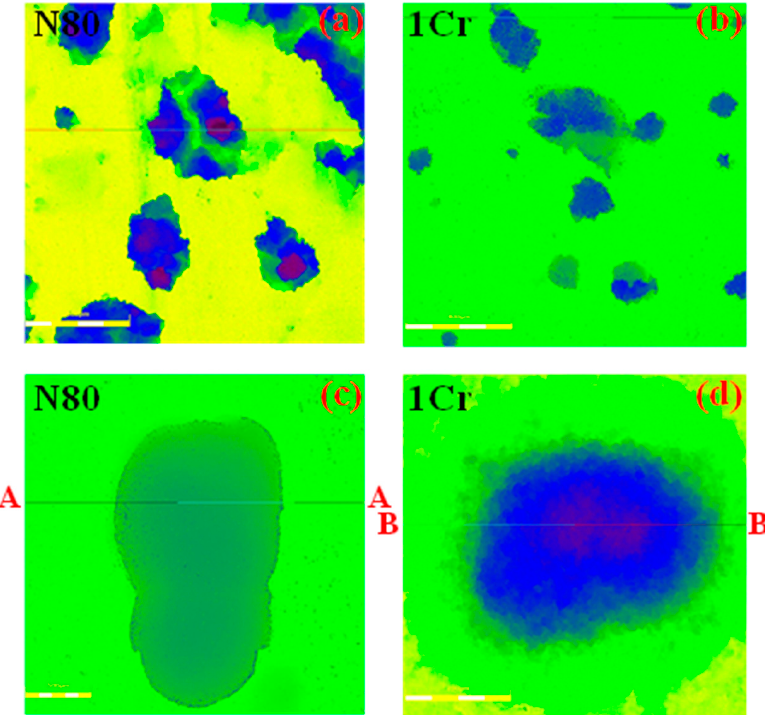
Figure 8. Micrographical analysis of the pi tt ing corrosion at lower temperature-partial pressure (50 °C-CO 2 : 0.30 MPa): ( a,b ): shows pi tt ing density; ( c,d ) Maximum pit size characterization.Note: A-A / B-B is the cross section at the maximum pi tt ing depth of the pi tt ing pit.